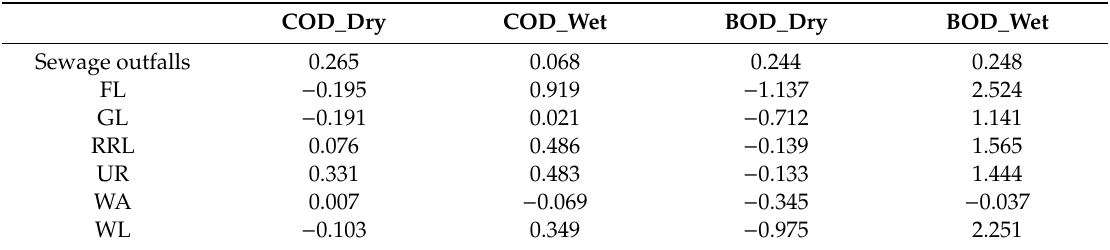
Table 5. Parameters of influence factors on COD and BOD from BN models at the EUC